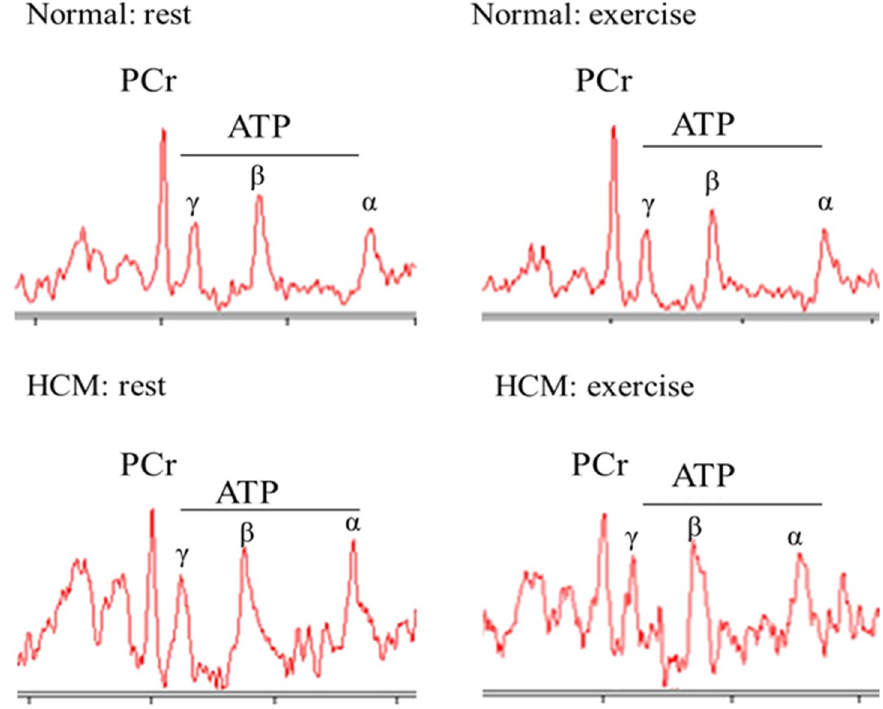
Figure 5. Examples of spectra in normal and hypertrophic cardiomyopathy. Reproduced with